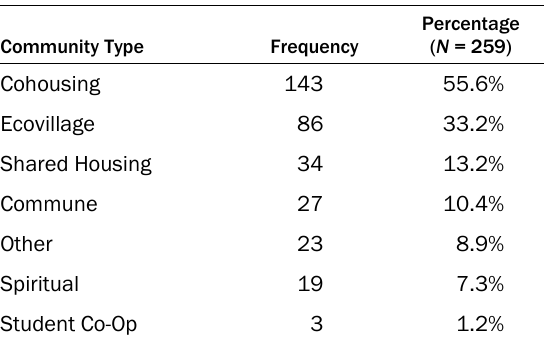
Table 2. Frequency of Community Type in the Sample